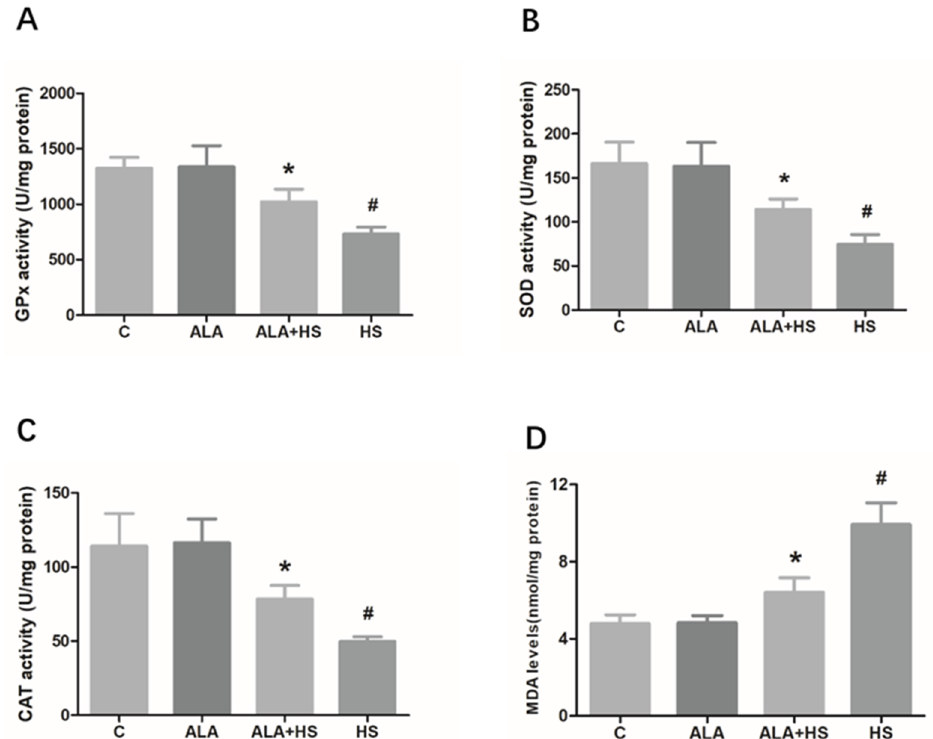
Figure 2. The effect of alpha lipoic acid on oxidative stress markers in the testes of chickens exposed to heat stress. Oxidative stress biomarkers, including ( A ) Glutathione peroxidase (GPx), ( B ) Superoxide dismutase (SOD), and ( C ) Catalase (CAT) enzyme activity, were analyzed using a colorimetric method with commercial kits. ( D ) Malondialdehyde (MDA) levels were measured using a colorimetric method. The statistical analysis results are shown as bar graphs. The data are presented as the mean ± SE of three independent experiments. Note: * p < 0.05 vs. HS group; # p < 0.05 vs. C group.